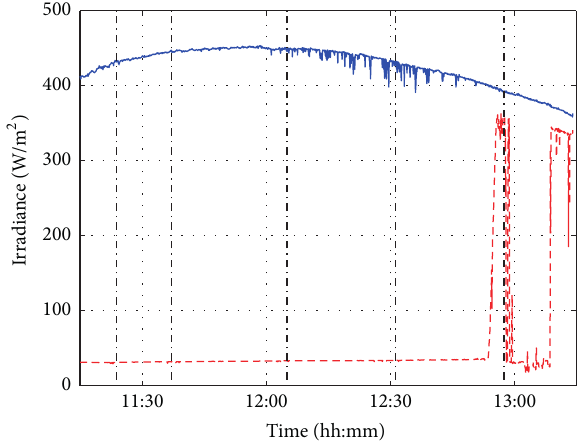
Figure 14: Irradiance profile received by String 4 during the electrical measurements of Figure 15 measured by sensors S5 (blue line) and S6 (red-dashed line) on December 4th, 2012. The moments when the electrical measurements were taken are marked with vertical dash-dotted